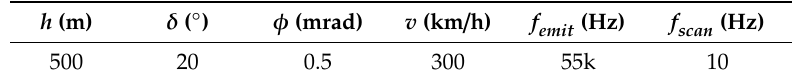
Table 3. Simulation